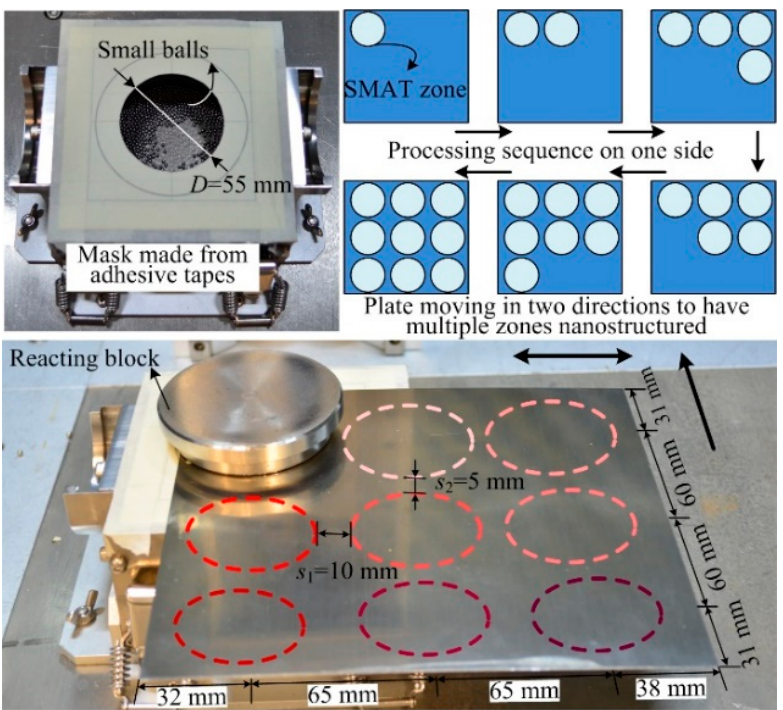
Figure 1. Experimental SMAT setup and the processing sequence to manufacture the multistable shell.